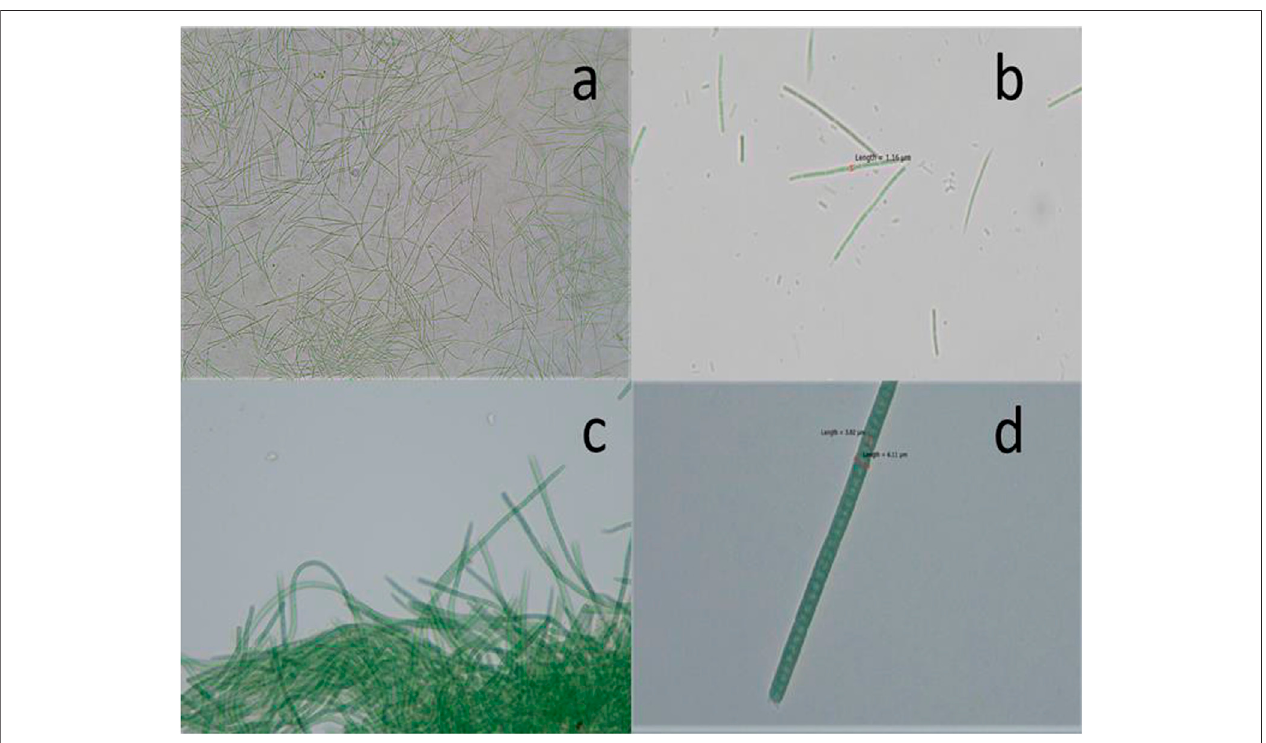
FIGURE 1 | Photomicrographs of ( A, B ) Euryhalinema sp. ( C, D ) Deserti fi lum sp.